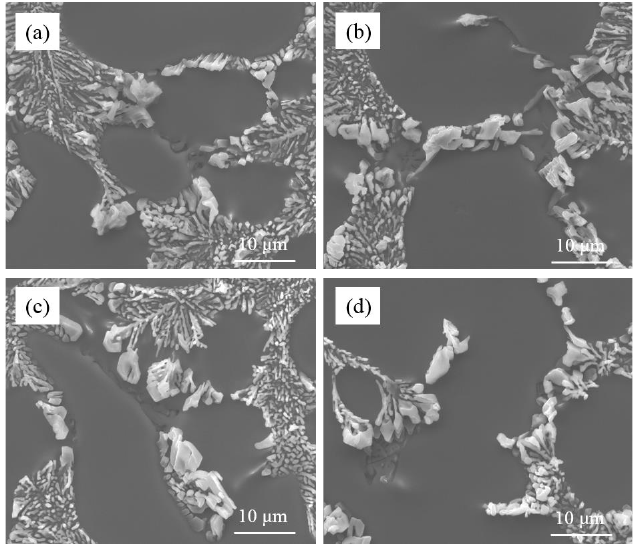
Figure 7. Microstructure of high pure Al-7Si-0.4Mg alloy with different modifier additions; ( a ) with 0.4 wt.% Na-modifier; ( b ) with 0.6 wt.% Na-modifier; ( c ) with 0.03 wt.% Sr; ( d ) with 0.06 wt.%